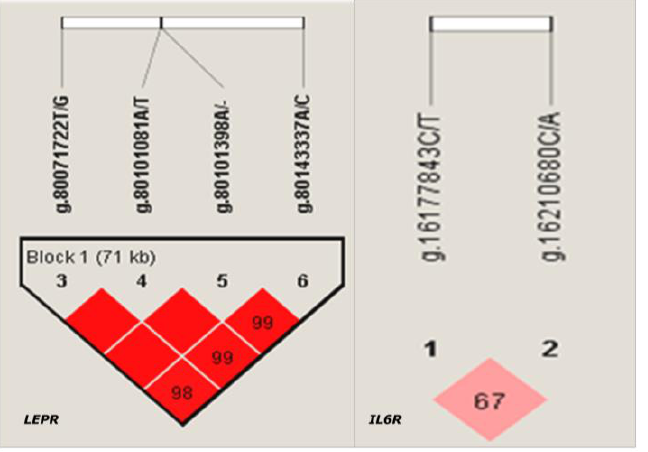
Figure 2. Haplotype blocks constructed based on linkage disequilibrium (LD) for gene IL6R and LEPR in Chinese Holstein cows.